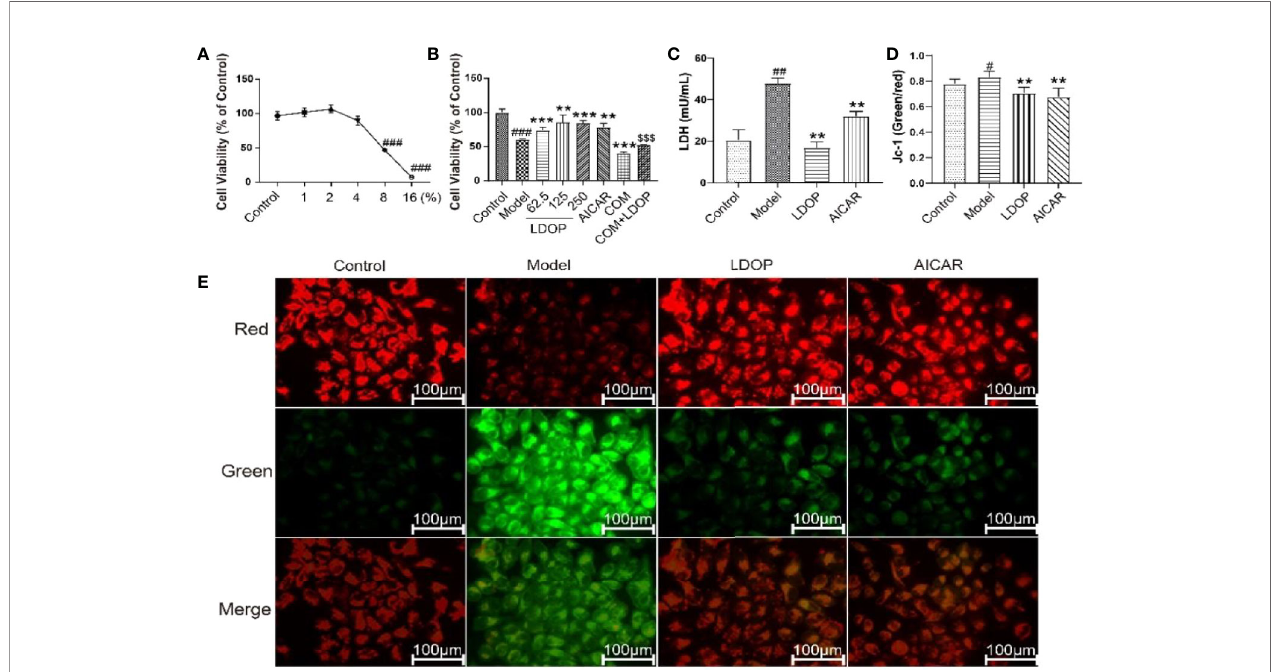
FIGURE 7 | Effects of ethanol and LDOP-1 on GES-1 cells viability measured by MTT assay, LDH release and mitochondrial membrane potential. Effects of ethanol (A) and LDOP-1 (B) on GES-1 cells were measured by MTT assay. LDH release (C) was measured by LDH Cytotoxicity Assay Kit. Mitochondrial membrane potential was detected by JC-1 assay Kit (D) . Immuno fl uorescence image of JC-1 measured by immuno fl uorescence technique (E) . In the mitochondrial membrane potential is high, JC - 1 gathered in the mitochondrial matrix (matrix), the formation of polymer (J - aggregates), can produce red fl uorescence; When the mitochondrial membrane potential was low, jc-1 could not accumulate in the matrix of the mitochondria. At this time, jc-1 was monomer and could produce green fl uorescence. Data are expressed as the mean±SD of three independent experiments. # P<0.05, ## P<0.01, ### P<0.001 compare the control group; **P<0.01, ***P < 0.001 compare model group, $$$ P < 0.001 compared with compound C group. LDOP stood for